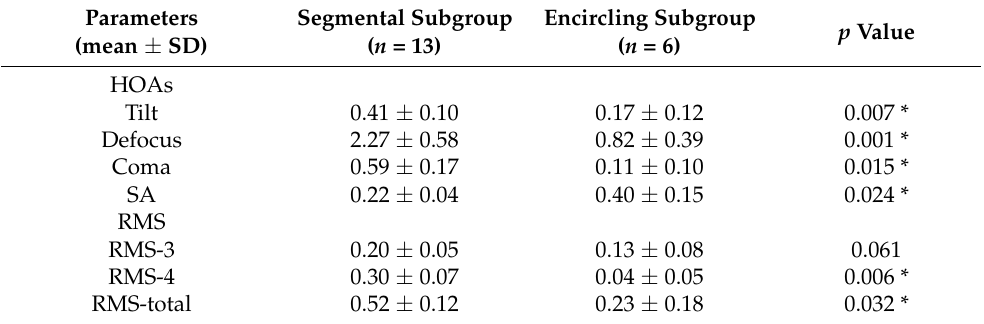
Table 4. The difference in higher order aberrations data between the segmental and encircling subgroups.